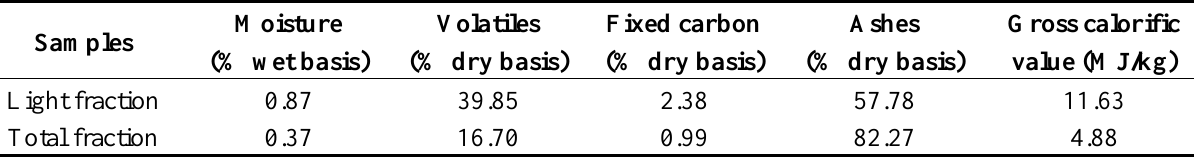
Table 5. Proximate analysis and GCV of milled